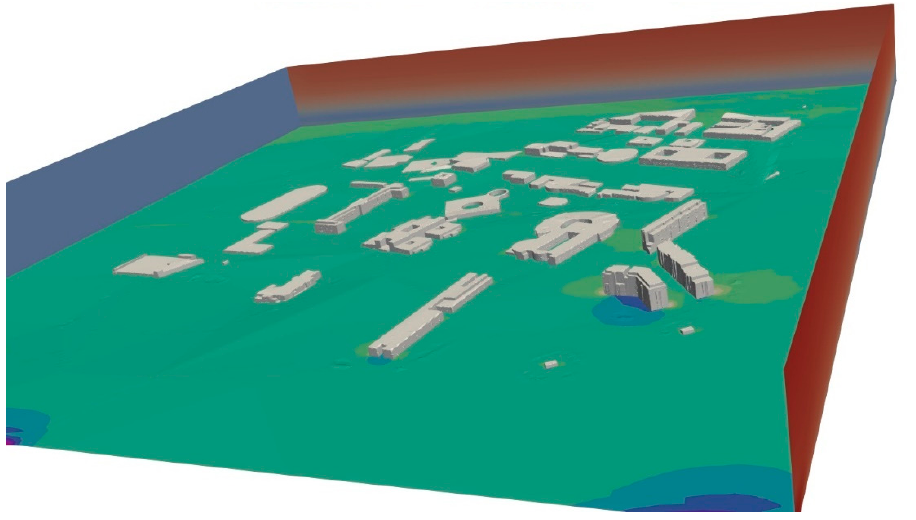
Figure 5. Domain